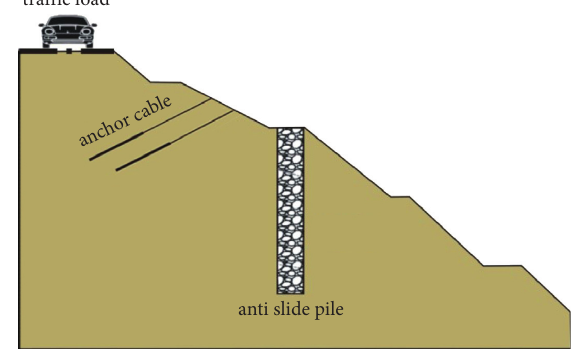
Figure 1: Schematic diagram of slope reinforcement with adjacent pile anchor composite